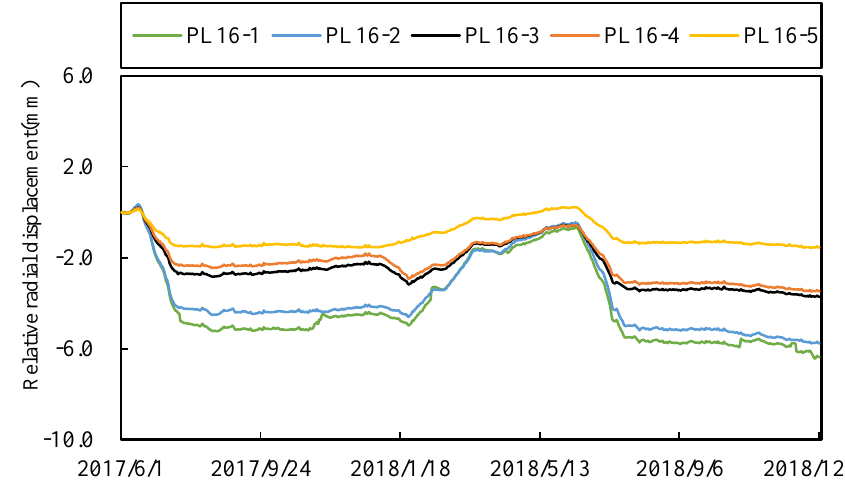
-10.0 Figure 8. Relative radial displacement distribution of Figure 8. Relative radial displacement distribution of PL16-1~PL16-5.